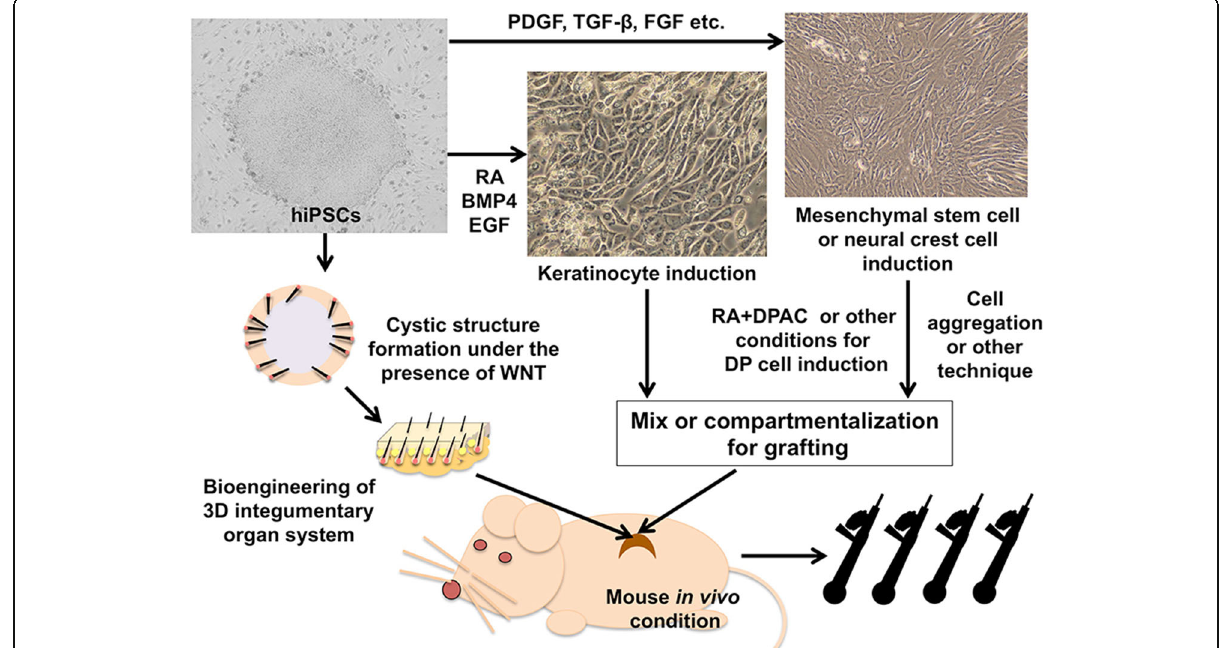
Fig. 7 Approaches for HF regeneration using of human induced pluripotent stem cells (hiPSCs). Currently, two respective approaches exist. In the “ classic ” approach, epithelial and mesenchymal components optimized for trichogenic EMIs are prepared and combined in vivo to form HF structures. Another approach takes advantage of pluripotency of hiPSCs, 3D integumentary organ systems with HFs are microdissected from cystic structures generated by grafting hiPSCs in vivo. HFs can be dissected from 3D integumentary organ systems for downstream applications including hair